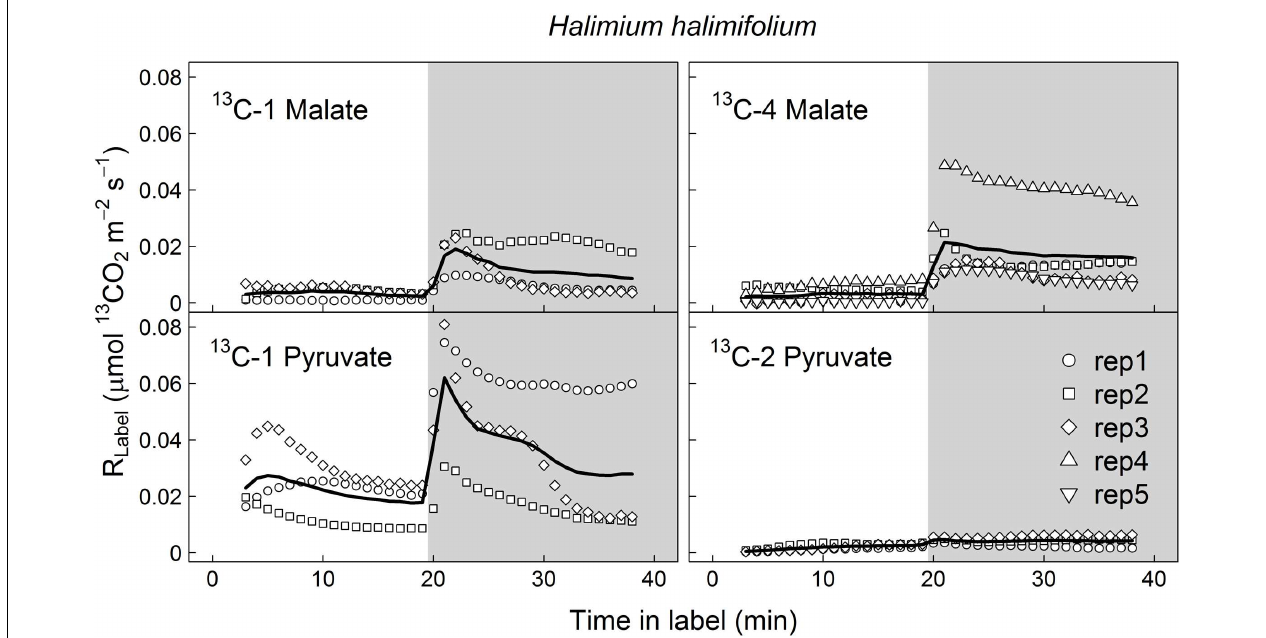
FIGURE 1 | Label-derived leaf 13 CO 2 respiration ( R Label , µ mol 13 CO 2 m − 2 s − 1 ) during light–dark transitions in Halimium halimifolium . Twigs with leaves were fed with position-specific 13 C-labeled malate ( 13 C-1, 13 C-4) or pyruvate ( 13 C-1, 13 C-2) for about 40 min (20 min in the light and 20 min in the dark). Gray areas denote dark periods. Black bold lines denote mean values, while symbols indicate single replicates ( n = 3–5 individuals).